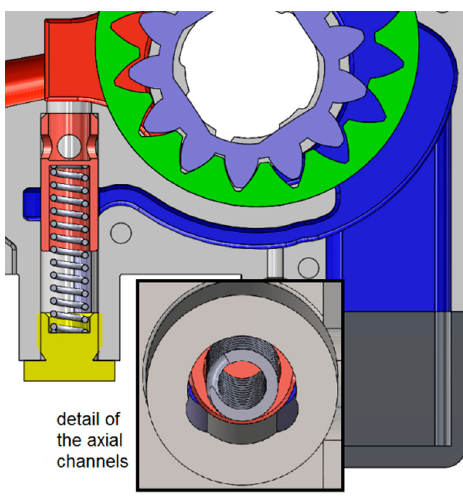
Figure 8. Cross section of the relief valve with a detail of the bottom view.